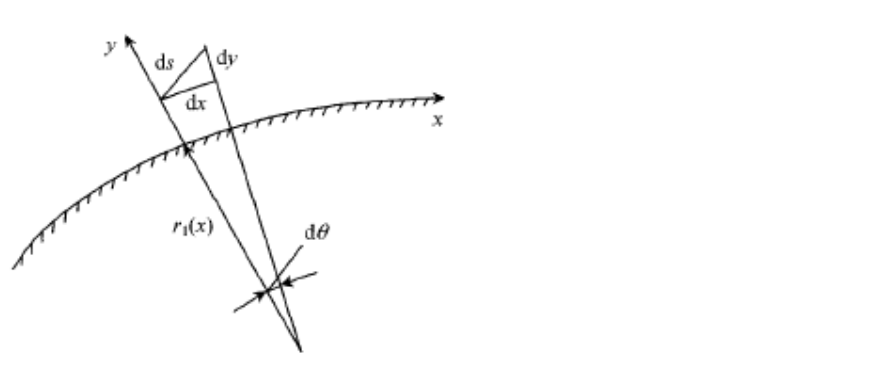
Figure 2. Curved coordinate system [34]. Reprinted with permission from ref. [34]. Copyright Year: 2008; Copyright Owner’s Name: Yonghuai Guo.